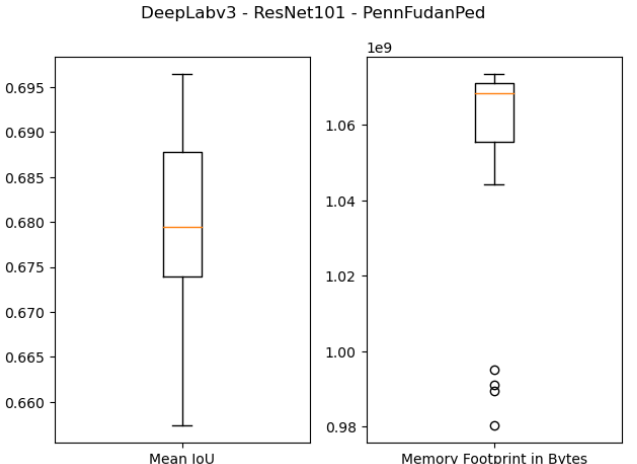
Figure 9. Boxplot results for the São Carlos Rivers dataset using the ResNet101 backbone and 1 GB of desired memory footprint.